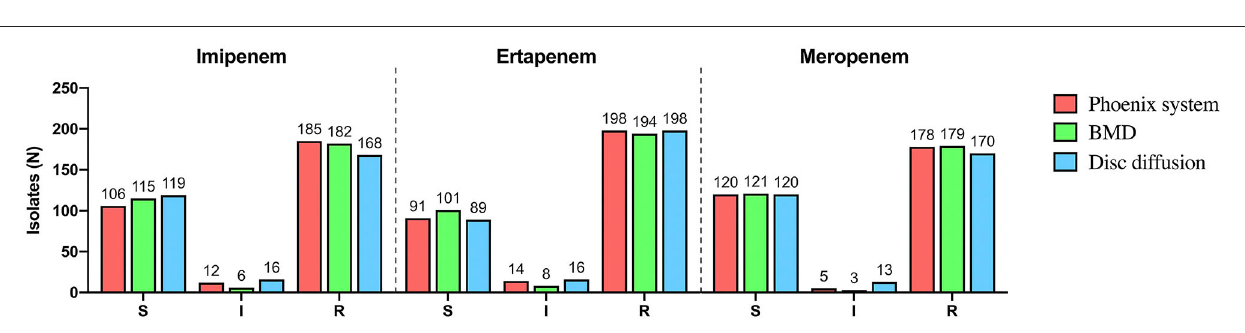
Figures 3D–F displayed the MICs and disk zoom diameter of three antibiotics by BMD and disk diffusion. Only in ertapenem, the number of drug resistance measured by the disk diffusion method was more than that of BMD (198 vs. 194), and the number of drug resistance of the other two drugs were nearly 10 less (imipenem: 168 vs. 182; meropenem: 170 vs.